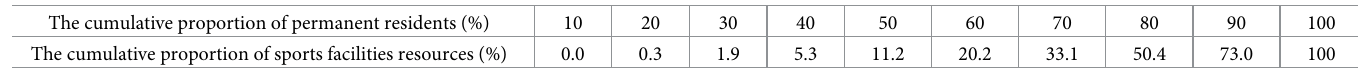
Table 4. Cumulative list of the proportion of permanent residents having access to public sports facilities resources. The cumulative proportion of permanent residents (%) The cumulative proportion of sports facilities resources